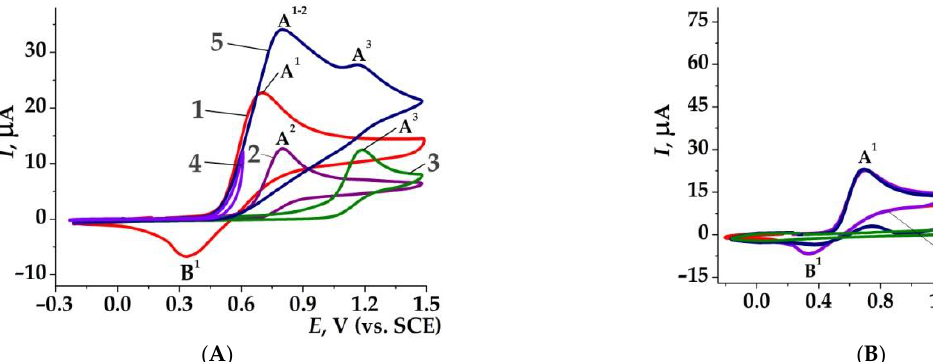
Figure 1. CV curves on Pt working electrode in 0.1M NaClO 4 in MeCN, ν = 0.10 V · s − 1 . ( A ) NH 4 SCN (0.002M)—1; 3-methyl-1 H -pyrazol-5-amine 1e (0.002M) — 2; 3-methyl-4-thiocyanato-1 H -pyrazol-5-amine 1f (0.002M) — 3; mixture NH 4 SCN/azole 1e (1:1) with the reverse scan from 0.60 V — 4; the same on the reverse scan from 1.45V — 5; ( B ) NH 4 SCN (0.002M) — 1; 2-methyl-5-thiophen-2-yl-7-(trifluoromethyl)pyrazolo[1,5-a]pyrimidine 10e — 2; 2-methyl-3-thiocyanato-5-thiophen-2-yl-7-(trifluoromethyl)pyrazolo[1,5-a]pyrimidine 10f — 3; mixture NH 4 SCN/ azole 10e (1:1) on the reverse scan from 1.20 V — 4; the same on the reverse scan from 2.10 V — 5.